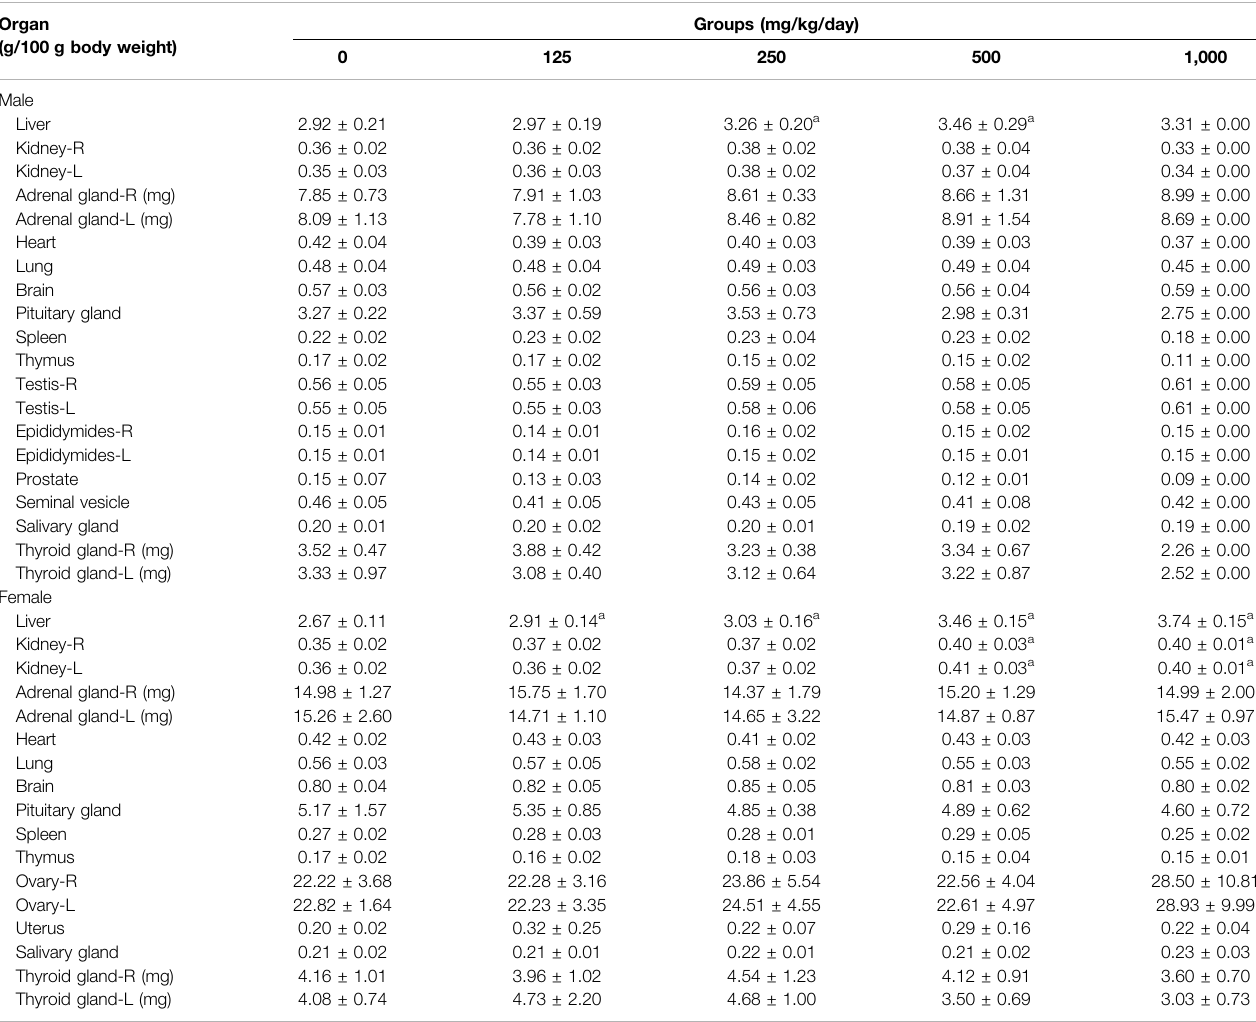
TABLE 3 | Toxicity of BCP on percentage of relative organ weight in male and female rats. Organ (g/100 g body